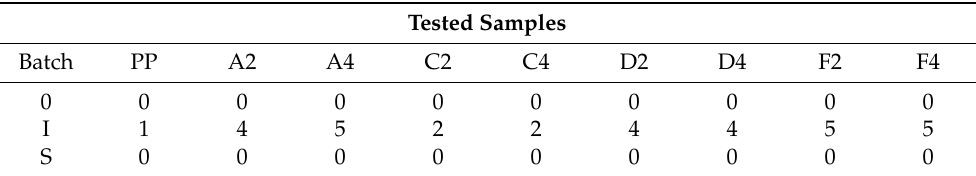
Table 5. Fungal growth on test samples (Method B’)—result of visual assessment of samples based on Table